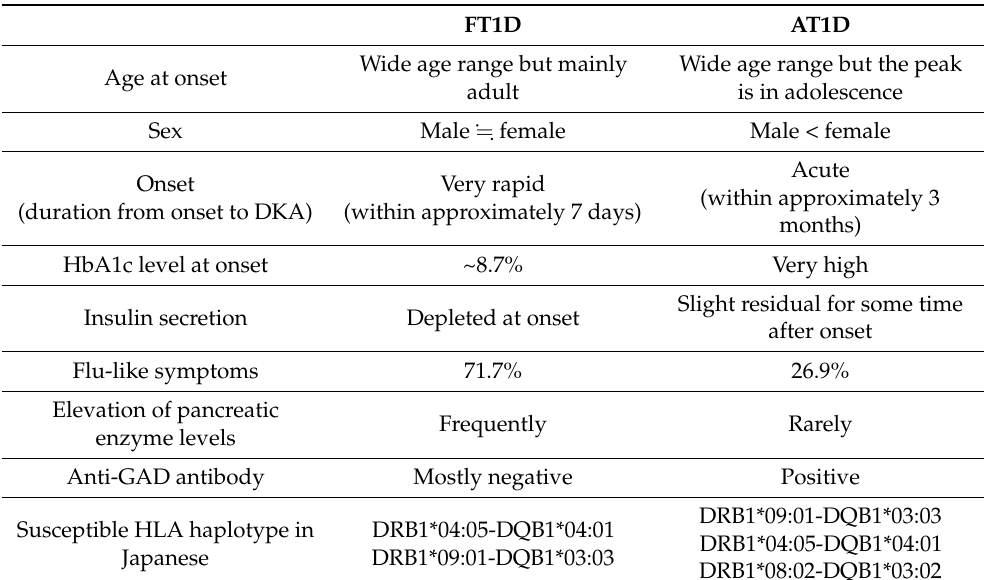
Table 1. Comparison of fulminant type 1 diabetes and autoimmune type 1 diabetes mellitus (created by authors based on